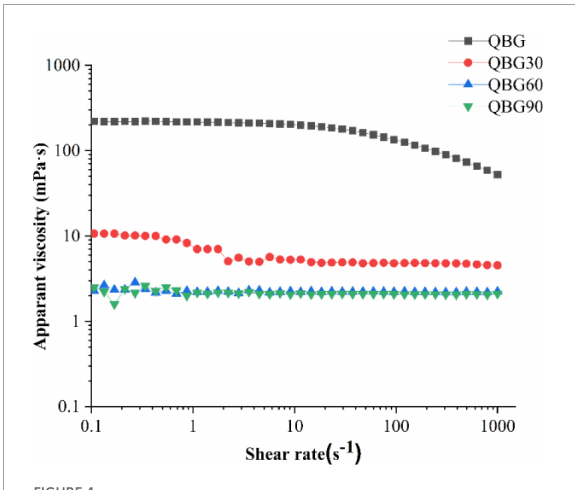
FIGURE4 The apparent viscosity of β -glucan samples on shear rates at a concentration of 2%.